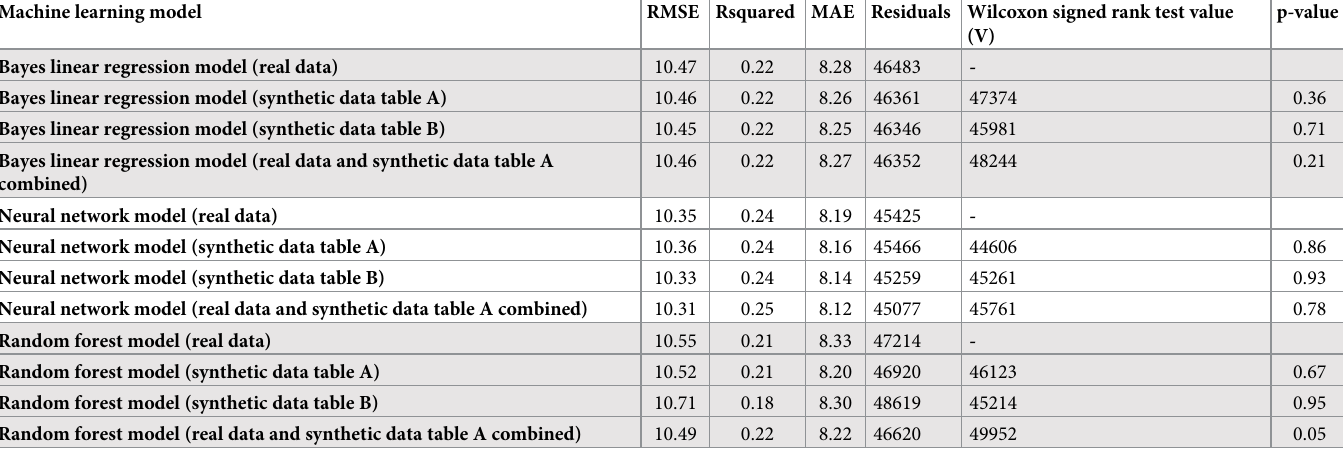
Table 3. Results of the machine learning models, trained on real or synthetic datasets. Each was tested on the same test dataset (real data). None of the p-values were < 0.05. Machine learning